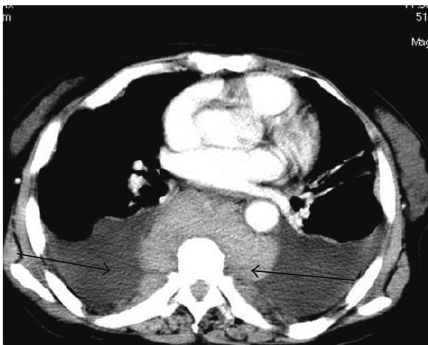
Figure 2: CT result shows multiple lymph nodes in the peritoneal cavity and retroperitoneal area. An enlarged liver and soft tissue masses were observed in the left kidney. On November 13, 2009, CT scan was performed, and the left arrow indicated enlarged liver with homogenous density, the middle arrow suggested enlarged lymph nodes in the abdomen, and the right arrow represented a soft tissue mass in the left kidney.